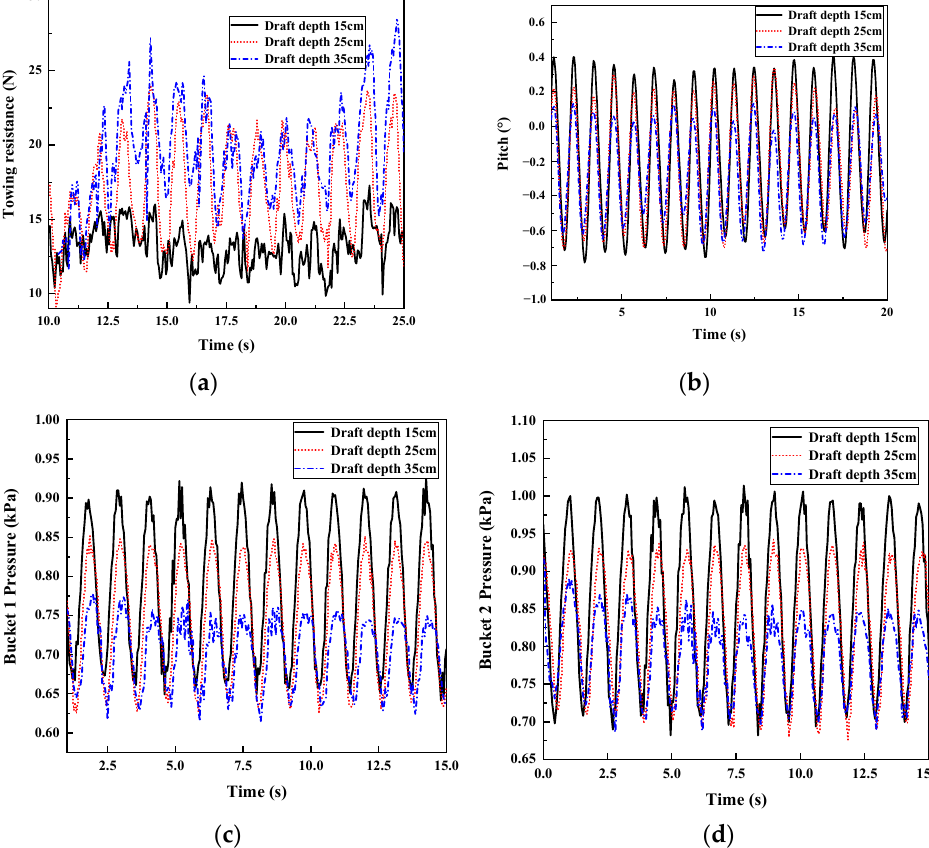
Figure 15. The dynamic response of the TBJF for different draft depths. ( a ) Towing force. ( b ) Pitch. ( c ) Bucket 1 pressure. ( d ) Bucket 2 pressure.